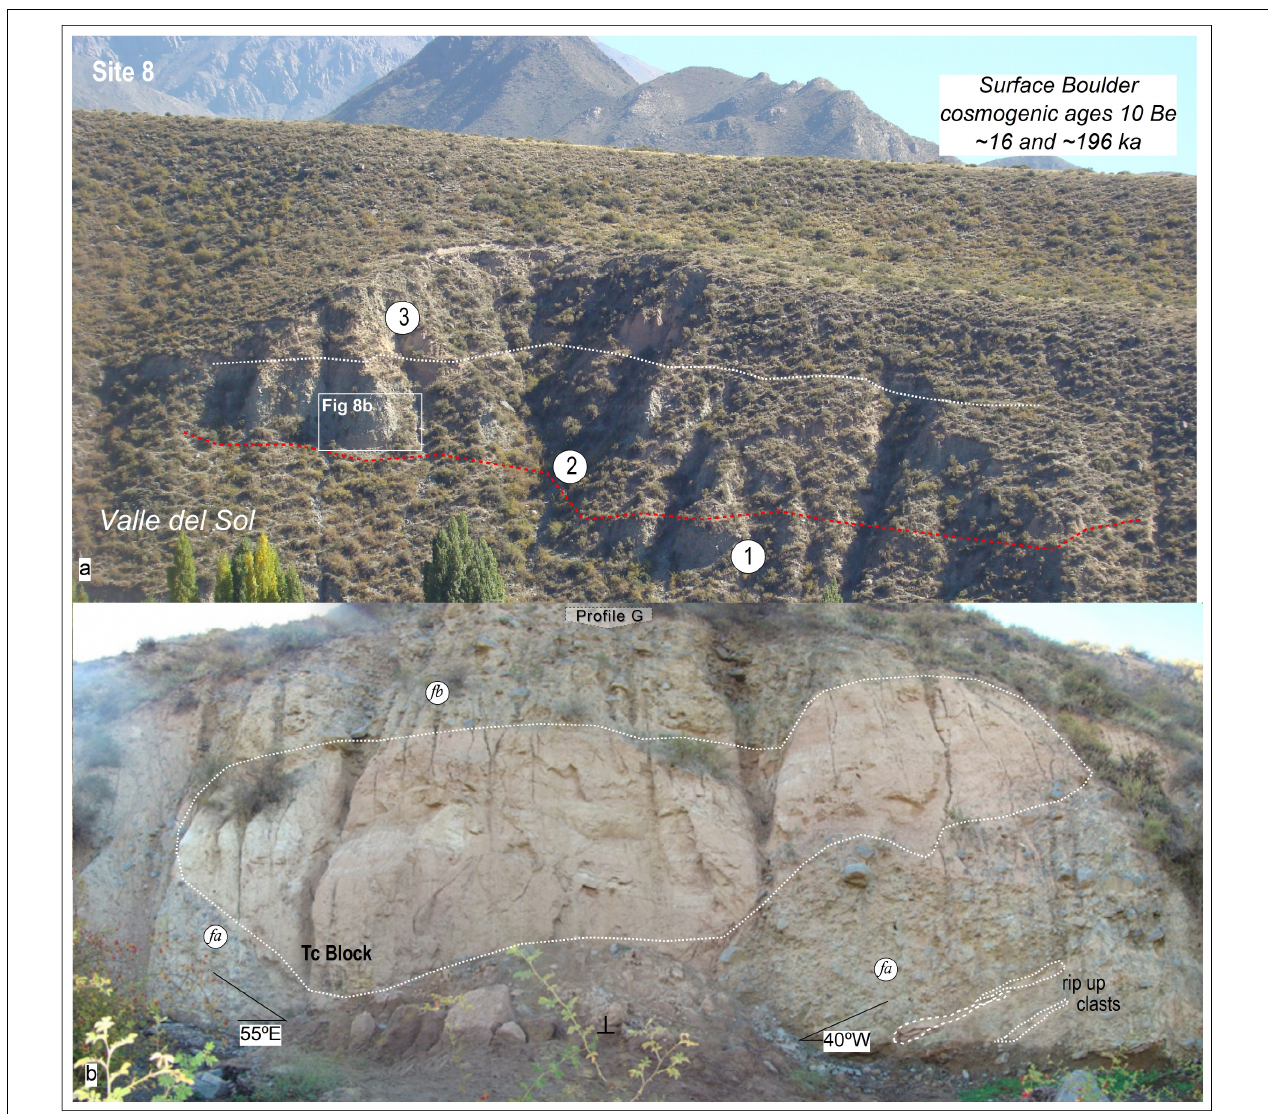
FIGURE 8 | Site 8 just in from of the Valle del Sol village. (a) Panoramic view of alluvial deposits along the Vacas Valley where 1. corresponds to alluvial deposits, 2. rock avalanche, and 3. alluvial deposits previously dated by cosmogenic nucleoids on surficial blocks ( 10 Be) ∼ 16 and ∼ 196 ka. (b) Detail of the rock avalanche deposit where a block of Tertian rocks (Tc block) is engulfed by the rock avalanches facies ( fa ) and facies ( fb ). Note that the basal layers are dipping in contrary directions containing rip up